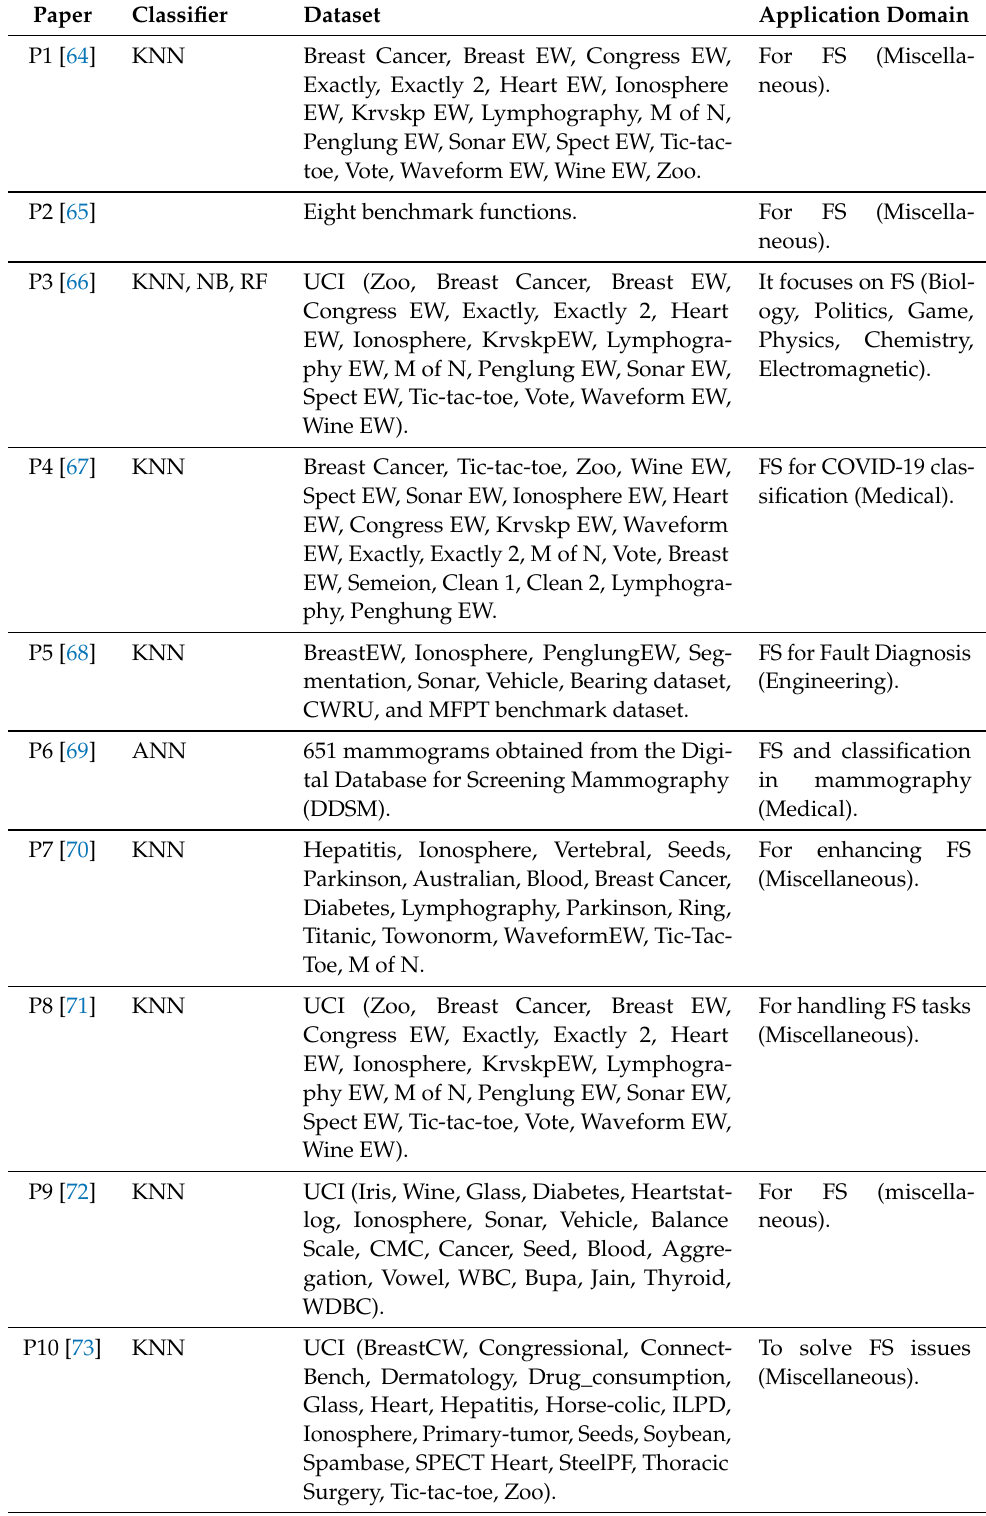
Table 4. Classifiers, datasets used, and